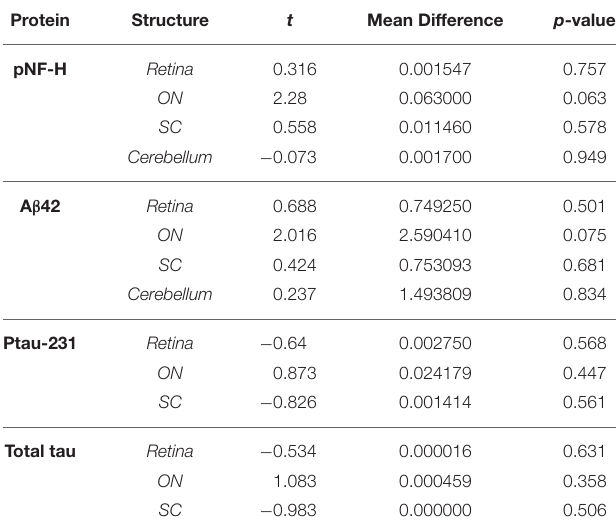
TABLE 2 | Young and aged D2G